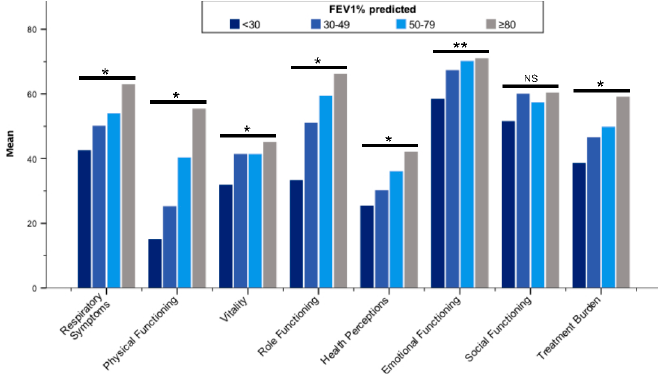
Figure 3. Mean Quality of Life Questionnaire-Bronchiectasis scores stratified by ppFEV 1 (categorized). Abbreviations: ppFEV 1 , forced expiratory volume in one second (% predicted); NS, not significant. * p < 0.001; ** p < 0.01. Differences between groups were assessed by the Kruskal–Wallis test.